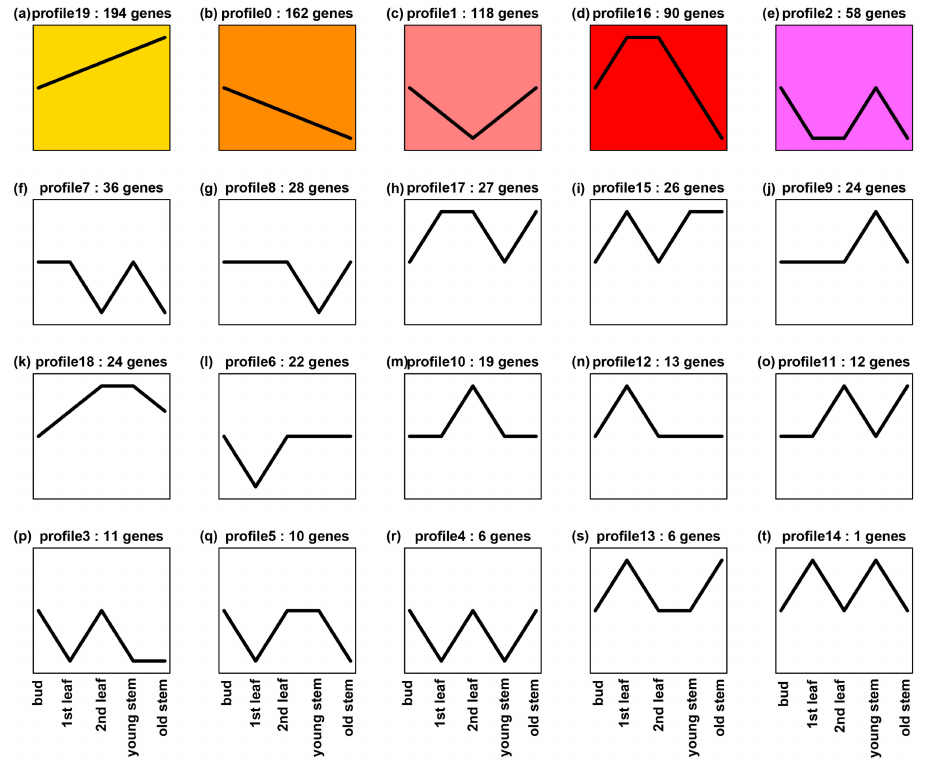
Figure 8. Twenty expression trend profiles established from coupled expression analysis of ANR and 885 transcription factor (TF) genes annotated from five transcriptomes sequenced for buds, the 1st leaf, the 2nd leaf, young stem, and old stem. ( a – t ) 20 expression trend profiles in 5 tissues. This result reveals that the expression trend of ANR is the same as those of 23 TF genes characterized in profile 18 ( k